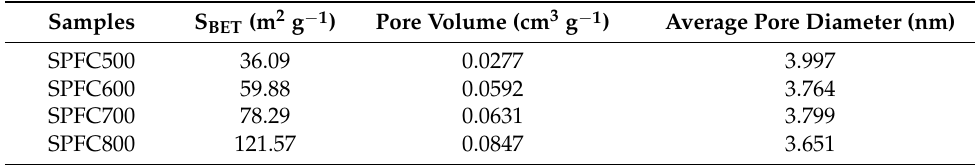
Table 1. The basic information of SPFCx.